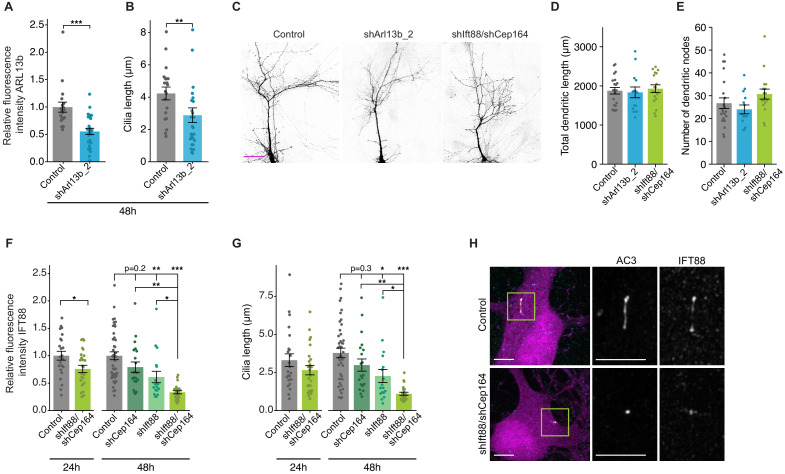
Gross neuronal morphology is unaltered upon acute knockdown of ciliary proteins.(A and B) Relative fluorescence intensities of immunolabeled ciliary ARL13b (A) and cilia lengths (B) in neurons transfected with the indicated plasmids 48 hr post-transfection. Each dot is a measurement from a single neuron. Values in A are normalized to values in controls. Bars are average ± SEM. ** and *** indicate p<0.01 and 0.001 for the indicated conditions (Wilcoxon rank-sum). n: Control = 19, shARL13b_2 = 26; three dissociations. (C) Representative images of DIV11 pyramidal neurons expressing the indicated plasmids 48 hr post-transfection. Scale bar: 50 μm. (D and E) Total lengths (D) and branch points (E) of apical-like dendritic arbors of cultured pyramidal neurons expressing the indicated constructs at 48 hr post transfection. Each dot is a measurement from a single neuron. Bars are average ± SEM. n: Control = 21, shArl13b_2 = 14, shIft88/shCep164 = 17; three dissociations. (F and G) Relative fluorescence intensities of immunolabeled ciliary IFT88 (F) and cilia lengths (G) in neurons transfected with the indicated plasmids 24 or 48 hr post-transfection. Each dot is a measurement from a single neuron. Values in F are normalized to values in controls. Bars are average ± SEM. *, **, and *** indicate p<0.05, p<0.01, and p<0.001, respectively for the indicated conditions. n: (24 hr) Control = 23, shIft88/shCep164 = 25; three dissociations; (48 hr) Control = 43, shCep164 = 20; shIft88 = 17, shIft88/shCep164 = 23; three dissociations. (H) Representative images of neurons expressing GFP alone (top) or shIft88/shCep164 and GFP (bottom). Cilia were immunolabeled with antibodies against AC3 and IFT88. Images at right show enlarged (2.5×) views of cilia (yellow boxes). Scale bars: 5 μm.
Figure 1—figure supplement 1—source data 1.Source data for Figure 1—figure supplement 1.